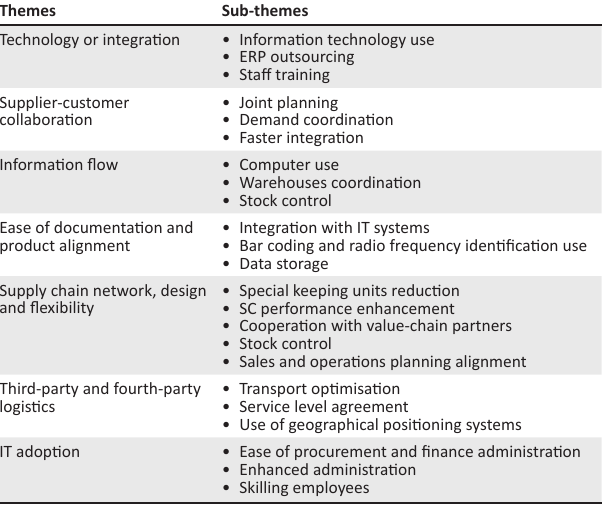
TABLE 1: Themes and sub-themes that emerged from the